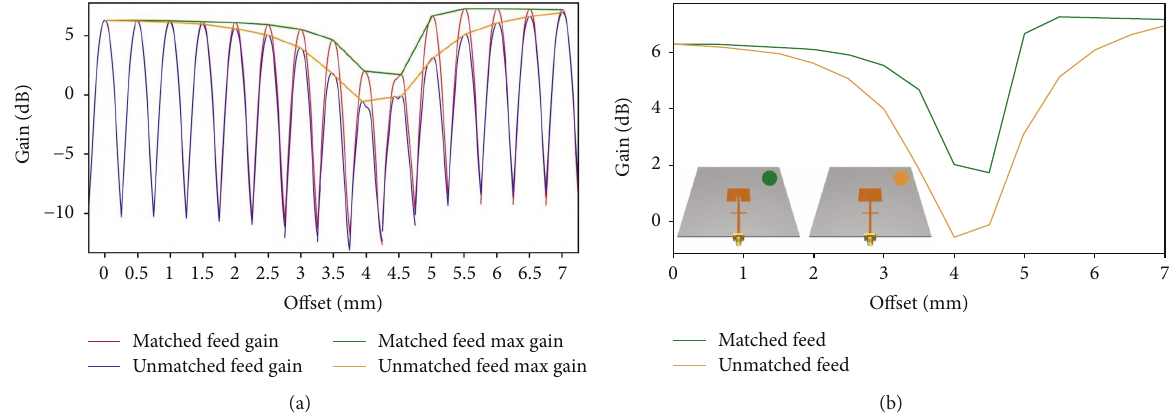
Figure 3: Simulated matched 50 Ω inset-fed copper antenna versus simulated unmatched 245 Ω edge-fed copper antenna: (a) simulated gains of 15 states; (b) simulated maximum gains of 15 states.